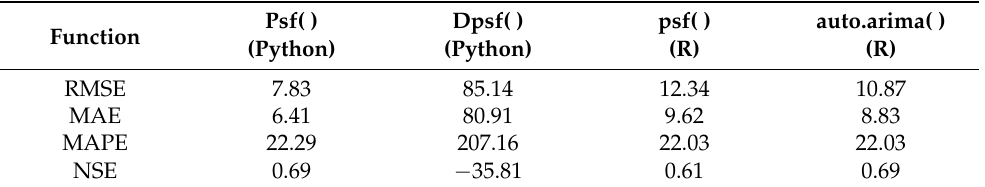
Table 12. Comparison of forecast methods with different error metrics for the “Average Tempera- ture” dataset.